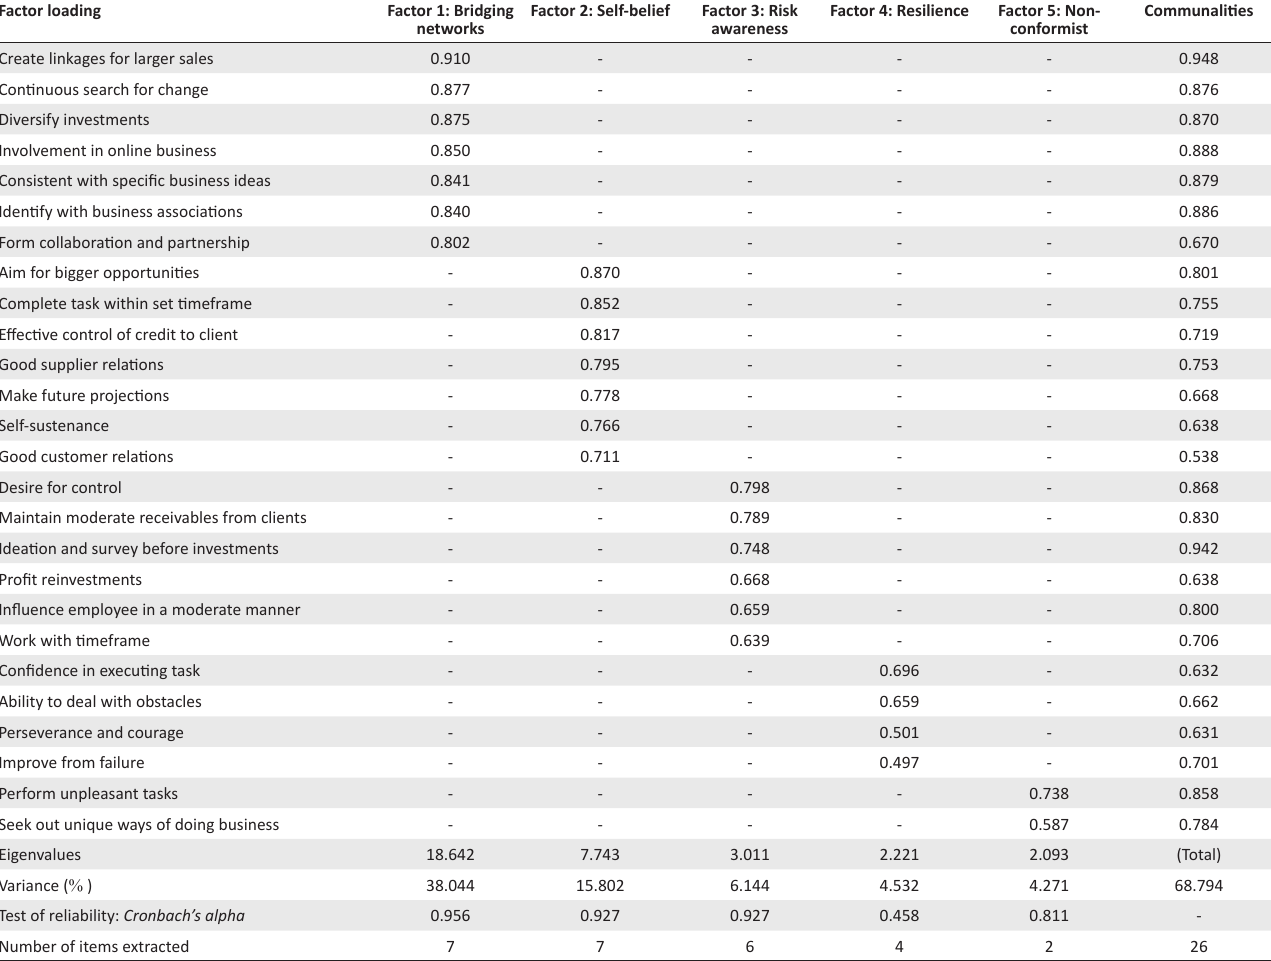
TABLE 1: Endogenous factor loading and communalities based on a principal component analysis with varimax rotation ( n = 280). Factor loading